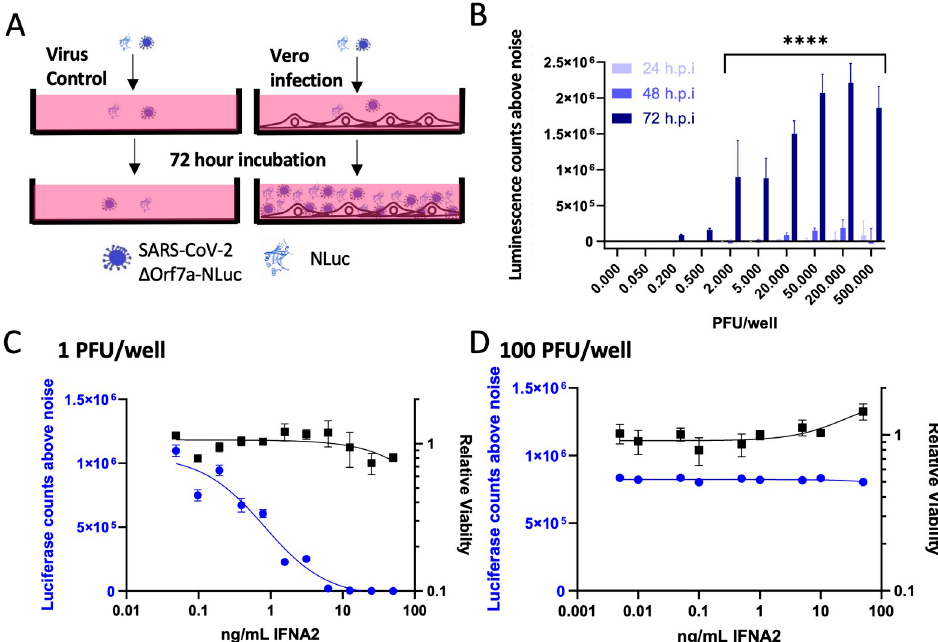
Fig 2. Timings of SARS-CoV-2- Δ Orf7a-NLuc virus replication. A) Schematic showing how SARS-CoV-2 Δ Orf7a- NLuc was used to assess virus replication. During virus replication as virus particles are released from the cell, or because of cell death, NLuc activity is detected in the conditioned medium together with virus particles. In subsequent assays the NLuc activity is recorded in the absence of cells, and NLuc signals above background signal are used to indicate the level of virus replication. B) The replication of SARS-CoV-2- Δ Orf7a-Nluc was monitored in a 96 well assay. Using 5000 Vero cells per well, increasing numbers of virus particles were added and monitored 24, 48 and 72 hrs post infection (h.p.i). Substantial and significant increases in NLuc activity were observed when only two plaque forming units (PFU) were added. Higher NLuc activity was associated with higher viral input. Even with higher viral inputs the substantial increases in NLuc activity occurred only after 72 h.p.i. C) Five thousand Vero cells were pre- treated with increasing doses of IFN α 2 for 24 hrs prior to infection with 1PFU SARS-CoV-2- Δ Orf7a-NLuc. NLuc activity and viability were assessed 72 h.p.i. demonstrating effective inhibition of virus replication. The blue line indicates the luminescence counts per second for DMSO treated controls. N = 3 replicate samples. D) As in C, 5000 Vero cells were treated with increasing doses of IFN α 2 for 24 hours prior to infection with 100 PFU SARS-CoV-2- Δ Orf7a-NLuc. With this higher titer, virus replication was not inhibited. The blue line indicates the luminescence counts per second for DMSO treated controls. N = 3 replicate